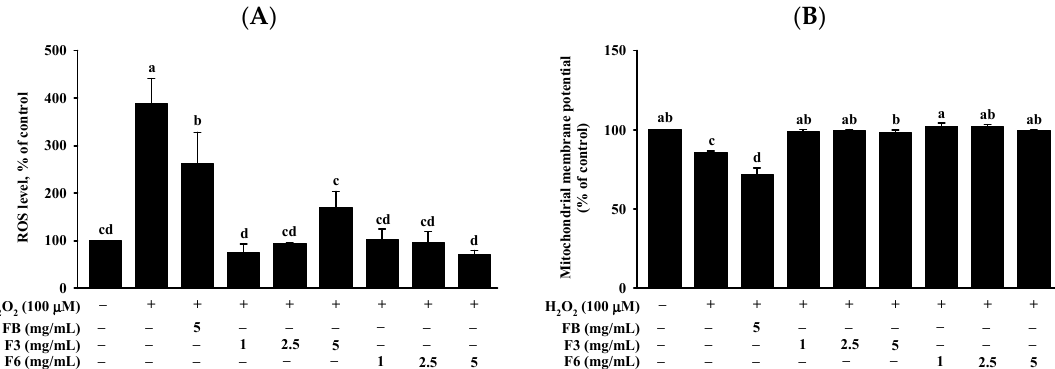
Figure 3. Effect of FB, F3, and F6 on ( A ) ROS content and ( B ) MMP integrity in H 2 O 2 -induced Clone-9 cells. Data are expressed as mean ± SD ( n = 3). Tukey’s tests were performed, with similar superscripts (a–d) among each group indicating non-significant difference ( p < 0.05). FB: fish bone; F3: fish bone fermented with Monascus purpureus for 3 days; F6: fish bone fermented with Monascus purpureus for 6 days.